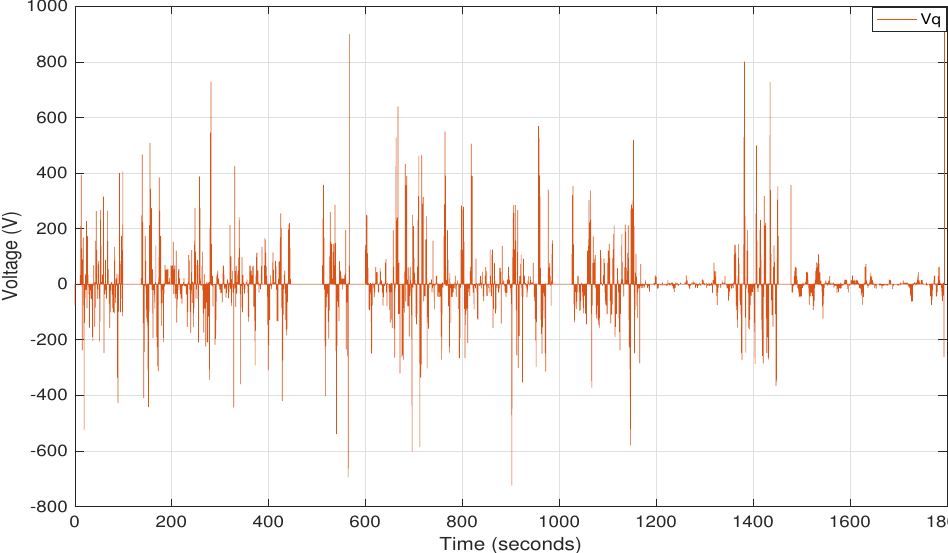
Figure 7. Real-time stator voltage v q obtained from electrified powertrain.